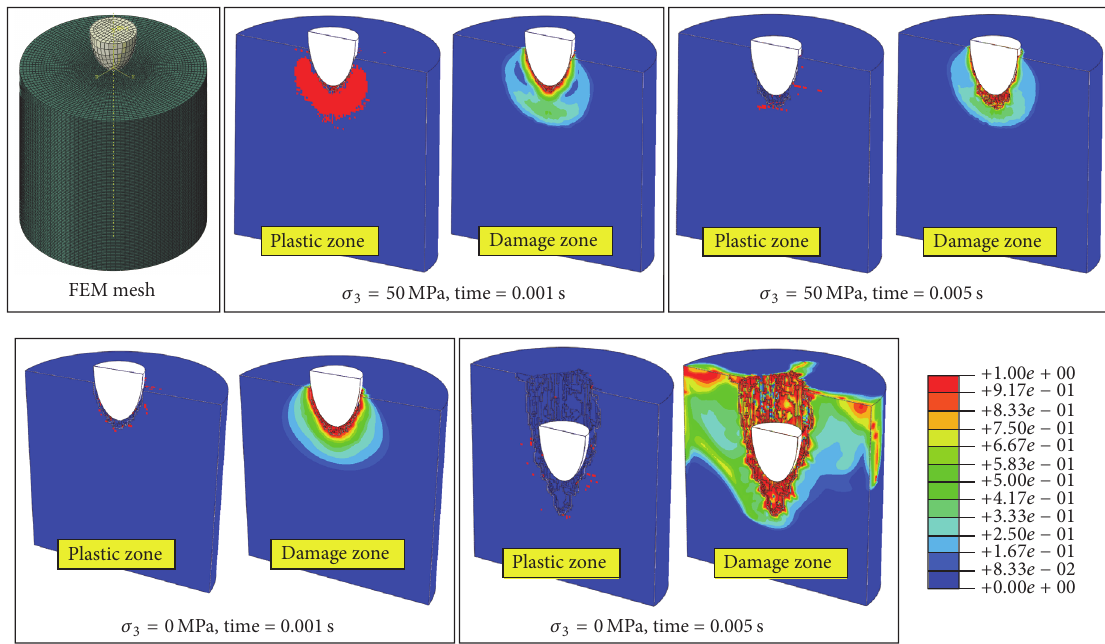
Figure 5: High-velocity impact and perforation by a rigid projectile into a rock stratum under different confining pressure (initial velocity = 1000